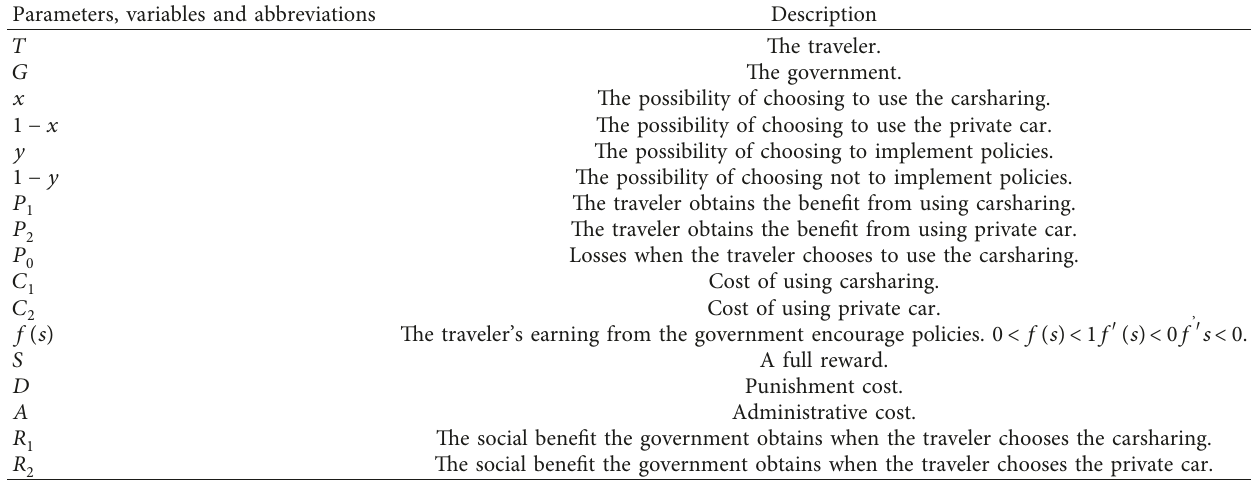
Table 1: Parameters, variables, and abbreviations.